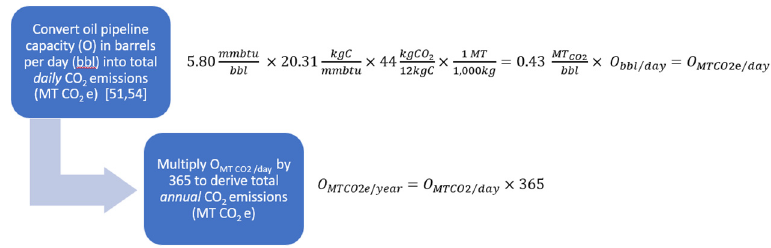
Figure 1. Stepwise process used to calculate potential annual CO 2 emissions (MT CO 2 e) of a coal facility.